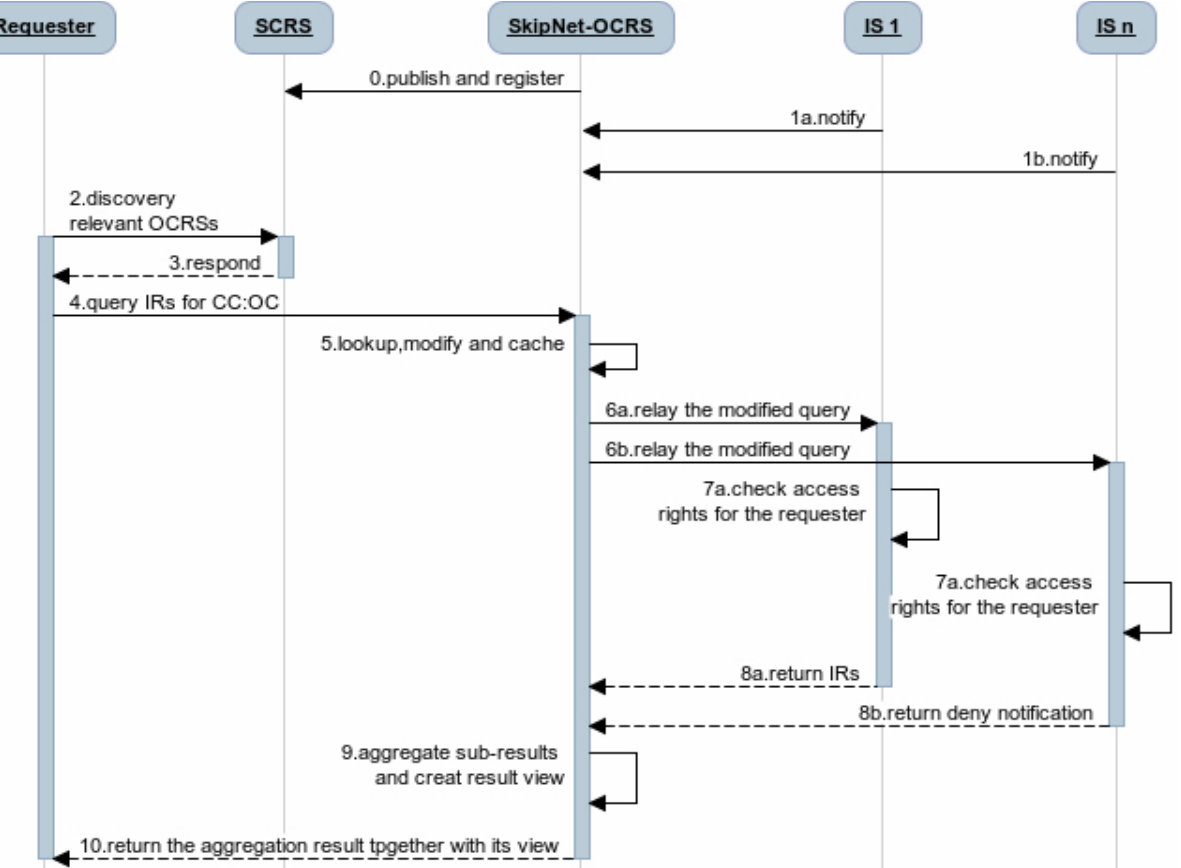
Figure 3. The query procedure of SkipNet-OCRS under QRRA